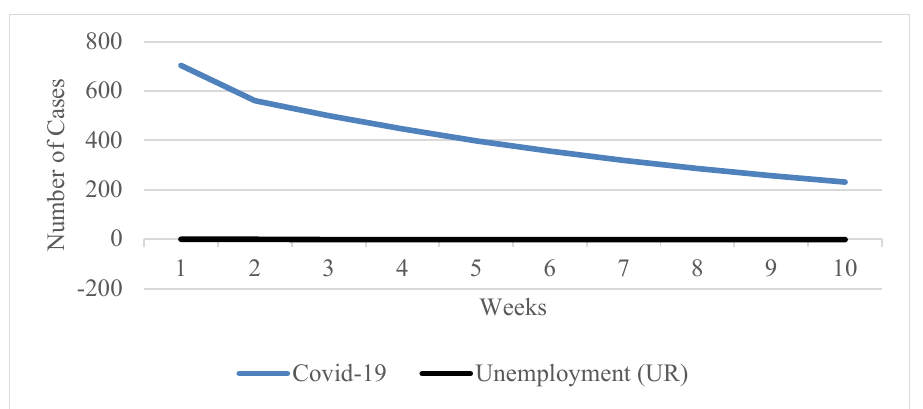
Fig. 3. Impulse response function of unemployment rate.